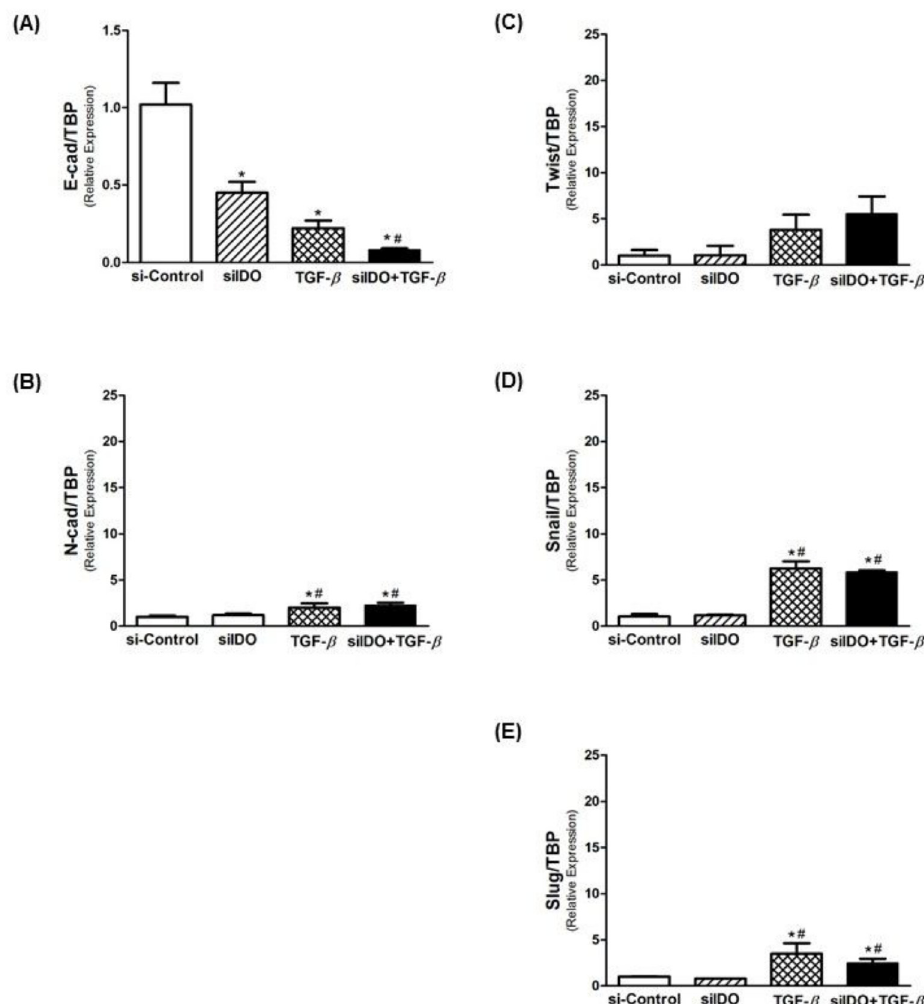
Fig 5. Effect of siRNA-mediated knockdown of IDO on EMT markers. Relative mRNA levels of (A) E- cadherin (epithelial marker), (B) N-cadherin (mesenchymal marker), and (C-E) EMT-associated transcriptional factors (Twist, Snail and Slug). siRNA-mediated knockdown of IDO was effective in reducing E-cad expression, and its association with TGF- β potentiated this effect. However, knockdown of IDO alone had no effect in N-cad expression, as well as in the expression of EMT-transcription factors. Only TGF- β acted inducing the expression of N-cad and EMT-transcription factors, and its association with siIDO did not change this effect. * p < 0.05 vs. Control; # p < 0.05 vs.